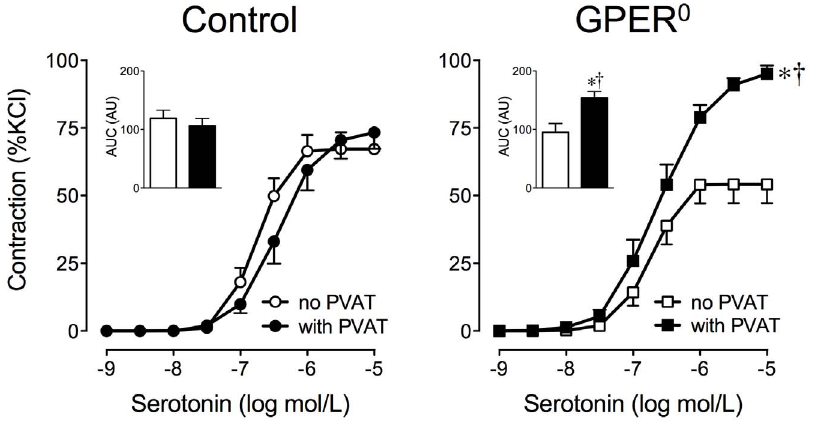
Figure 2. Potentiating effect of perivascular adipose on serotonin-induced contractions in mice with monogenic obesity. Aortic rings with and without perivascular adipose (PVAT) from monogenetic obese GPER 0 or lean WT (control) mice were exposed to increasing concentrations of serotonin. Inset: Area under the curve (AUC) of the concentration-response curves is expressed as arbitrary units (AU). # , control without PVAT ( n =7); , control with PVAT ( n =6); % , GPER 0 without PVAT ( n =6); & , GPER 0 with PVAT ( n =7). * p , 0.05 vs. aortic rings without perivascular adipose; { p , 0.05 vs.